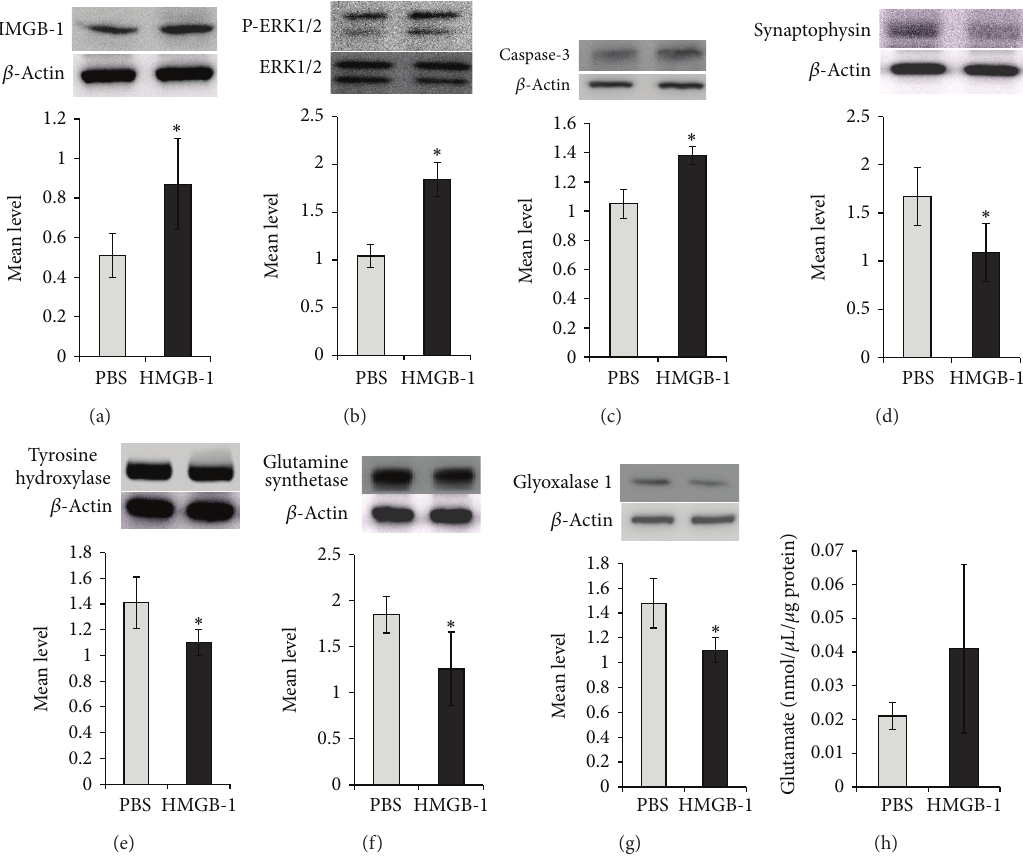
Figure 2: Western blot analysis of rat retinas. Intravitreal administration of high-mobility group box-1 (HMGB1) induced a significant upregulation of the expression of HMGB1 (a), activated extracellular signal-regulated kinase 1 and 2 (ERK1/2) (b), and cleaved caspase-3 (c) and a significant downregulation of the expression of synaptophysin (d), tyrosine hydroxylase (e), glutamine synthetase (f), and glyoxalase 1 (g) compared to intravitreal administration of phosphate buffer saline (PBS). Glutamate assay revealed that injection of HMGB1 tended to increase retinal glutamate expression, but this was not significant (h). Each experiment was repeated at least 3 times with fresh samples. A representative set of samples is shown. Results are expressed as mean ± SD of at least 6 rats in each group. ∗ 𝑃 < 0.05 compared with